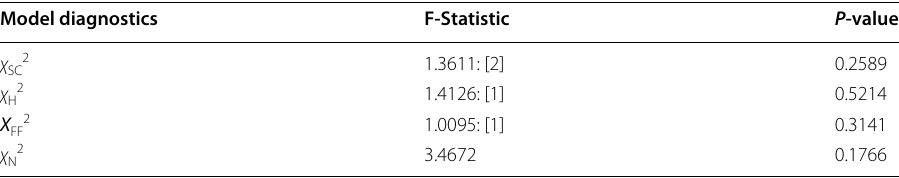
χ SC2 denotes the Breusch‑Godfrey Serial Correlation LM test, χ H2 denotes the Breusch‑Pagan‑Godfrey conditional heteroskedasticity test, Χ FF2 denotes the Ramsey RESET test, and χ N2 denotes the Jarque–Bera normality test. Values in [] represent the number of lags selected